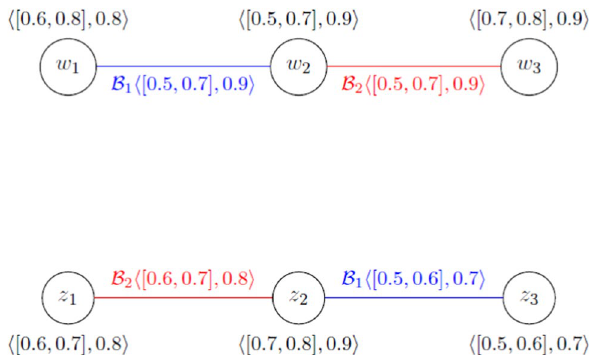
Fig. 12 The CFGSs of G = ( A , B 1 , B 2 ) and G � = ( A � , B 1 , B 2